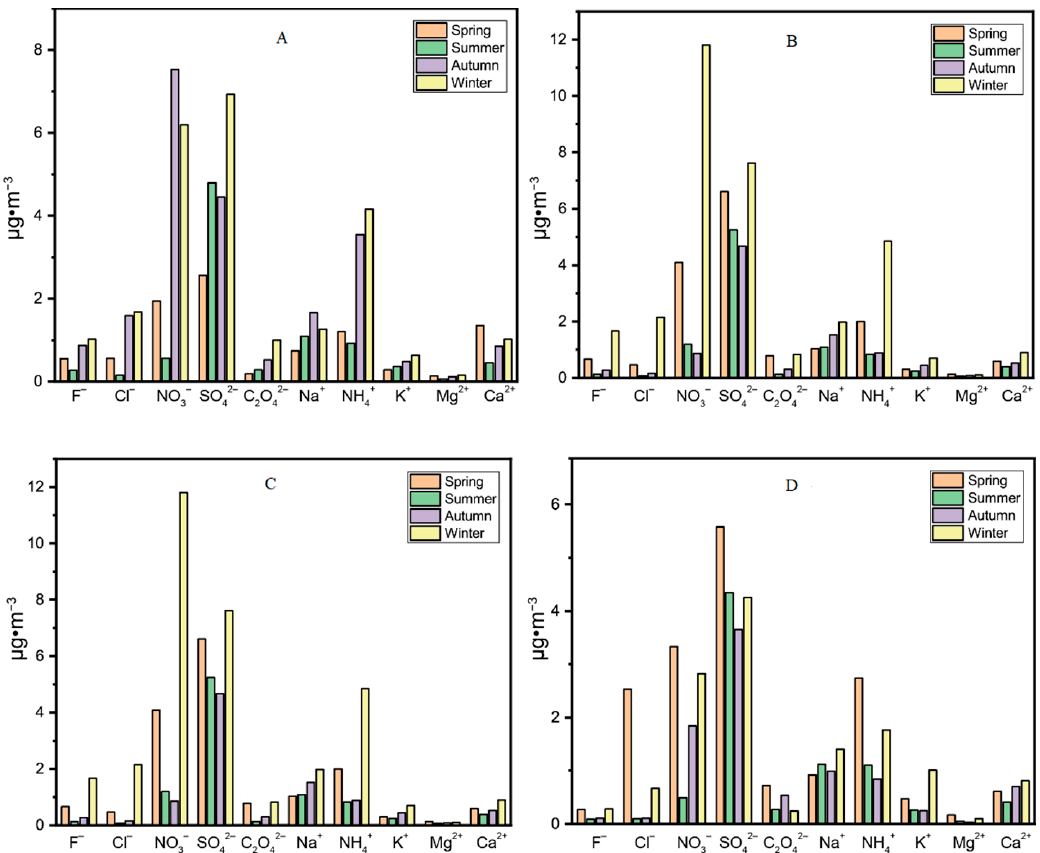
Figure 3. Distribution of water-soluble ions at four sampling sites in Xining, China ( μ g ‧ m − 3 ). Note: ( A ) = FPH, ( B ) = GID, ( C ) = QHU, ( D ) = YLV